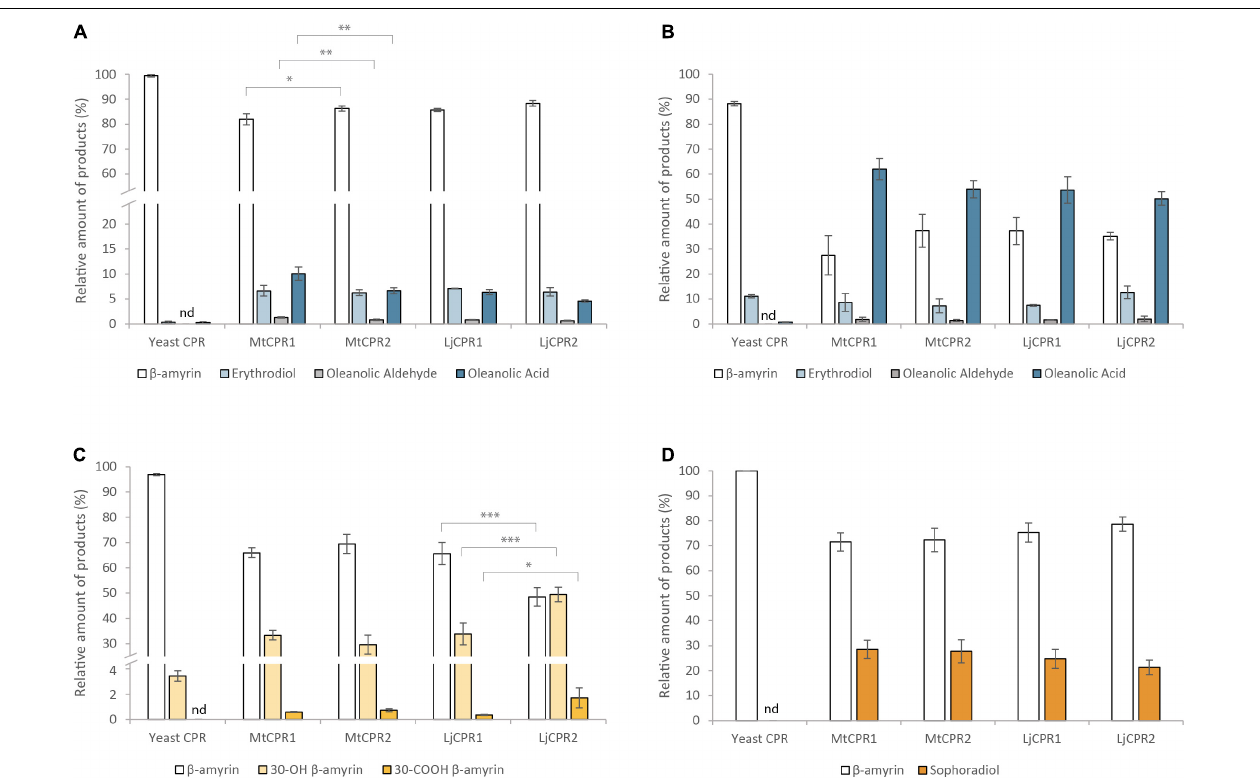
FIGURE 9 | The relative amount of triterpenoid produced using different combinations of CYPs and CPRs from M. truncatula and L. japonicus in the engineered PSIII yeast strain. Triterpenoid profiles from (A) MtCYP716A12 , (B) LjCYP716A51 , (C) MtCYP72A63 , and (D) LjCYP72A61 co-expressed with different CPRs. Triterpenoids content were measured relative to uvaol as internal standard. Data have been presented as mean ± SE ( n = 3). nd, signal below detection limit. Single-factor ANOVA was used for statistical comparisons. Values were considered statistically significant at * P < 0.05, ** P < 0.01, and *** P < 0.001.